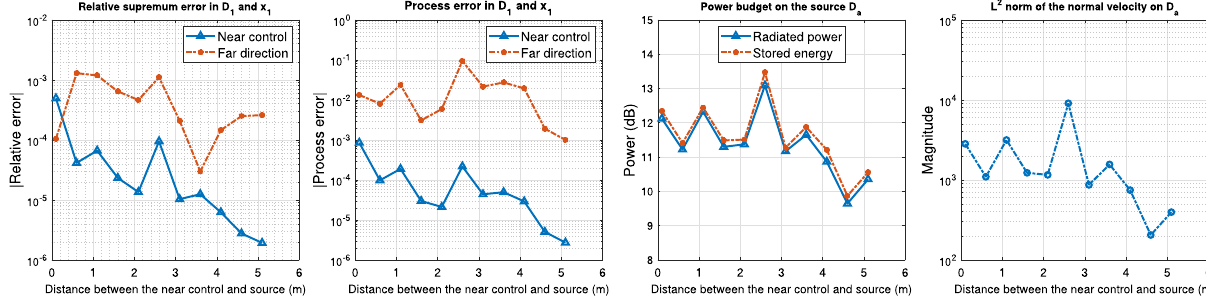
Figure 16. Results showing the control accuracy and the power budget varying with the distance between the source and the control region. From left to right, (1) Supremum error. (2) Process error. (3) Power budget on D a . (4) L 2 norm of normal velocity v n on D a